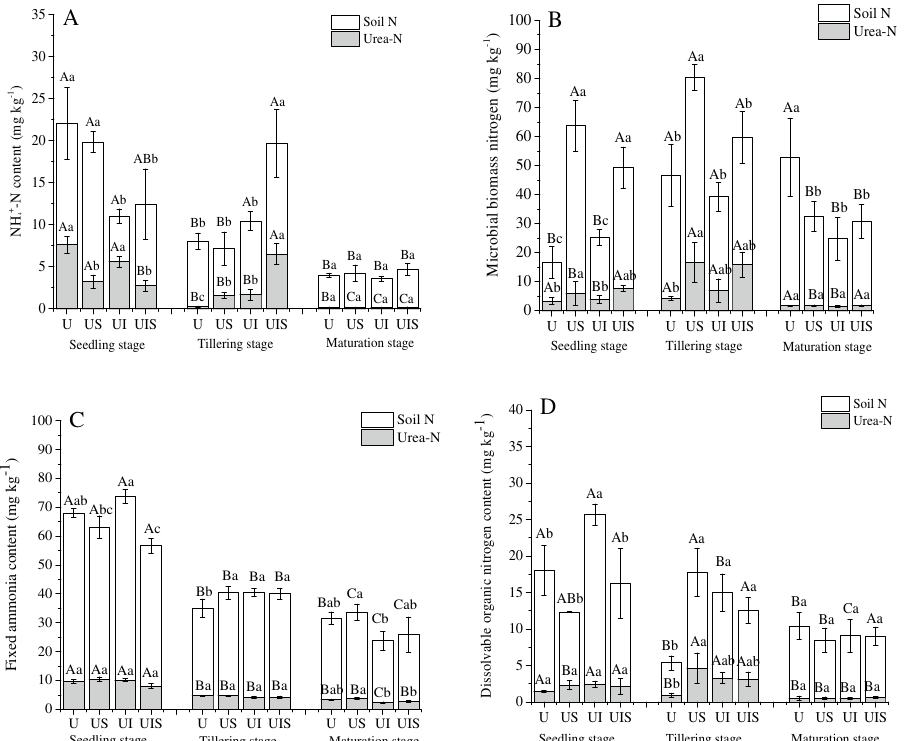
Figure 1. Soil and urea-derived nitrogen with straw, inhibitor and nitrogen fertilizer application at three sampling stages. U: 15 N labeled urea; US: 15 N labeled urea + straw; UI: 15 N labeled urea + inhibitor; UIS: 15 N labeled urea + inhibitor + straw. ( A ) Ammonium (NH 4 + -N), ( B ) Microbial biomass nitrogen (MBN), ( C ) Fixed ammonium (FA), ( D ) Dissolved organic nitrogen (DON). Different capital letters represent significant differences of the same treatment at different sampling times; different lowercase letters represent significant differences among treatments during the same sampling period (Duncan, P < 0.05).